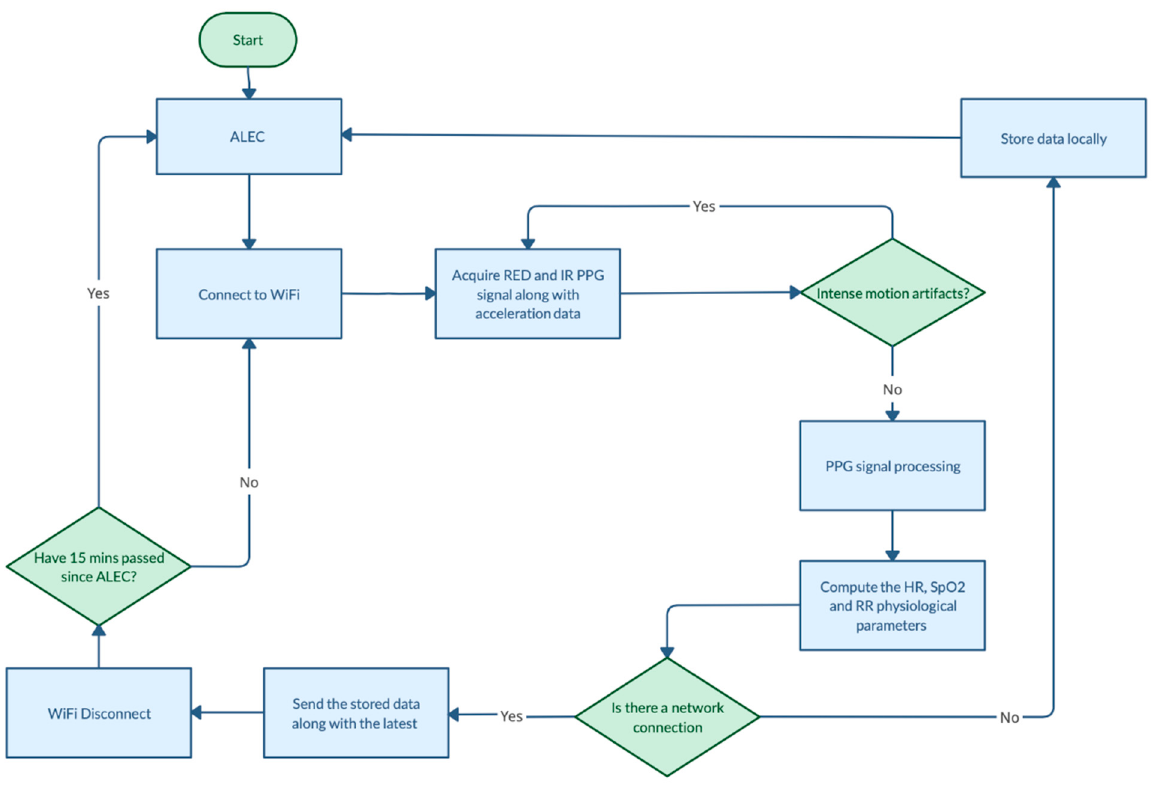
Figure 3. Flow chart of the algorithm.